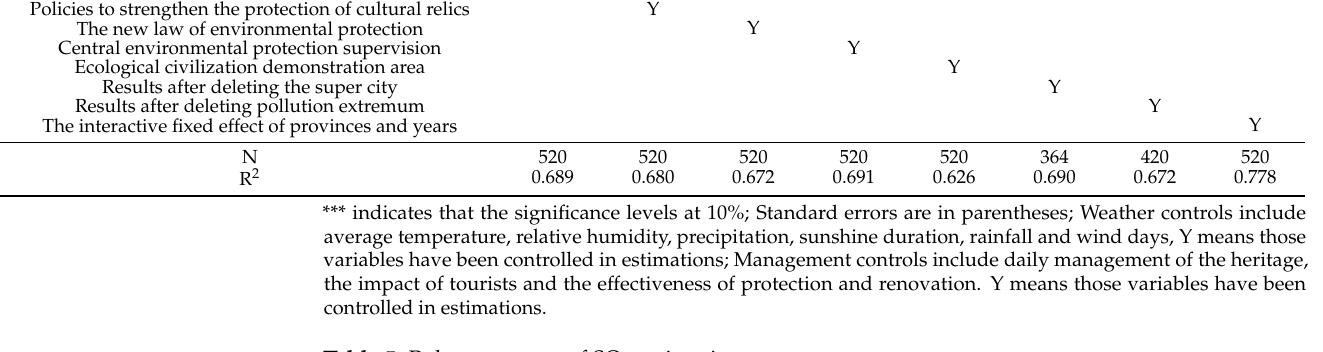
Table 5. Robustness test of SO 2